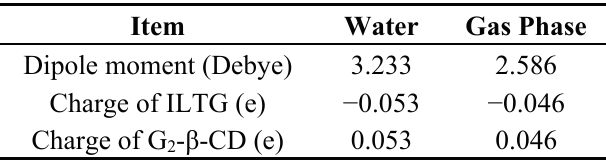
(B3LYP/6-31+G(d):PM3) calculations. Item